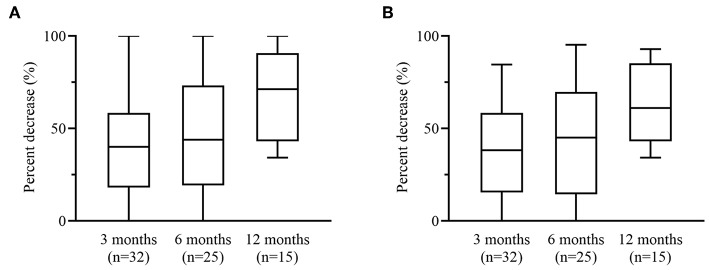
Percentage change of motor and all countable seizures. Median percentage change at 3, 6, and 12 months in (A) motor seizures and (B) all countable seizures. Boxplots show median value with 25th and 75th percentile. Whiskers denote minimum and maximum.